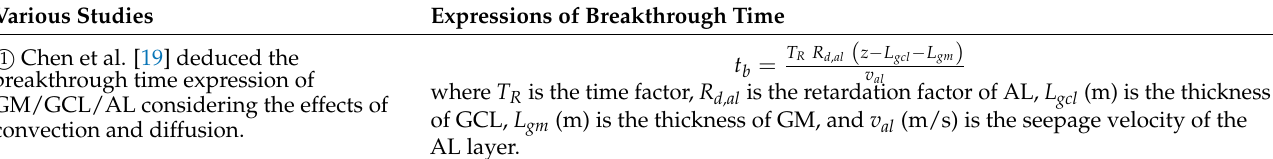
Table 6. Expressions of breakthrough time of pollutants through composite